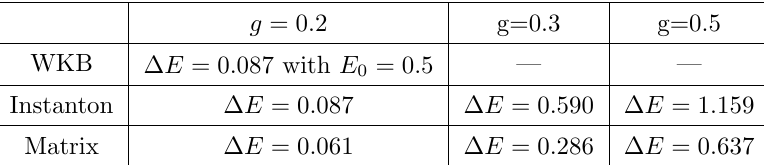
Table 1 . Both WKB and Instanton approximations to (cid:1) E work best when g is small. In the cases of g = 0 : 3 and 0 : 5, E 0 is already larger than the height of potential barrier, so the WKB approach is not